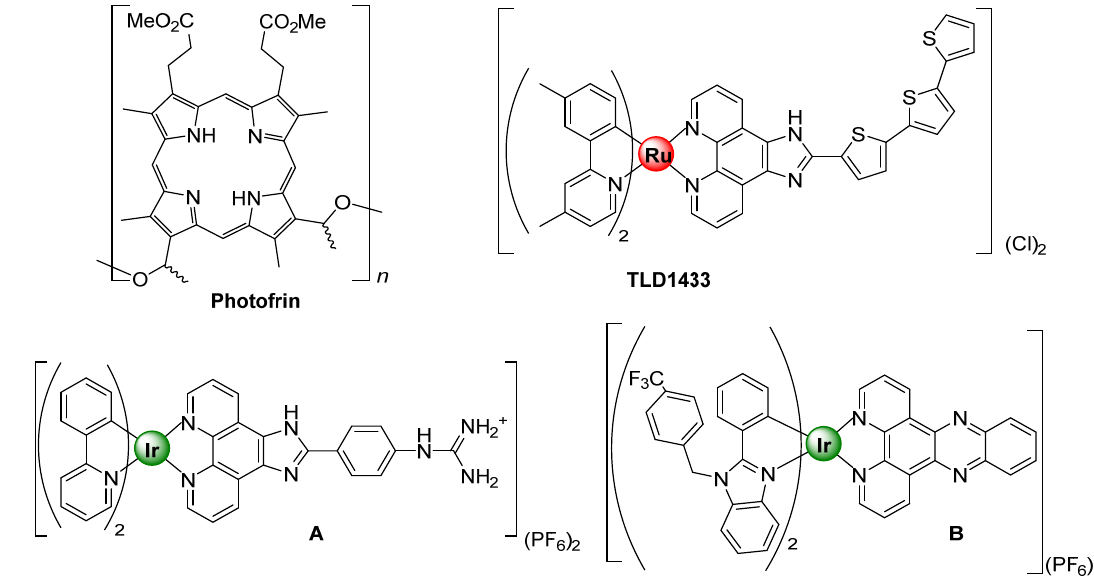
Figure 1. Chemical structures of Photofrin, TLD1433, and complexes ( A ) and ( B ) [8,18,22,23].